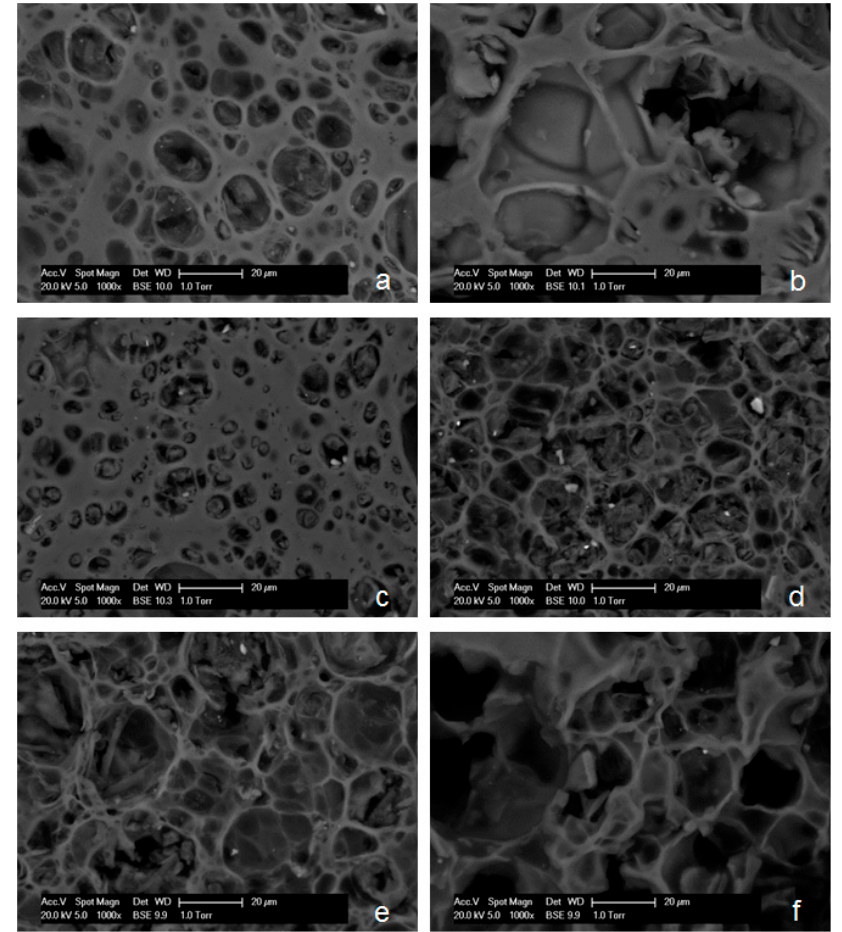
Figure 5. The cross-sectional ESEM images of calcium alginate capsules fabricated with A/R ratios of: ( a ) 60/40, ( b ) 50/50, ( c ) 40/60, ( d ) 30/70, ( e ) 20/80 and ( f ) 10/90.